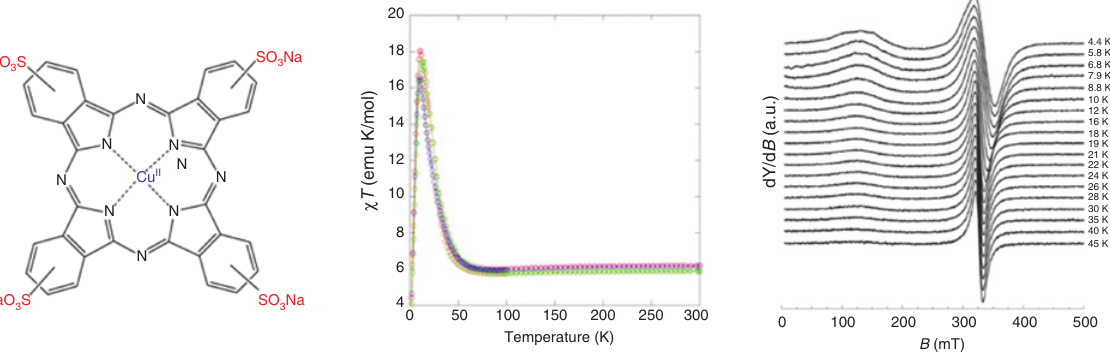
Figure 22: Left: phthalocyanines tetrasulfonates sketch [M = Co(II), Ni(II),Cu(II)]. Middle: magnetic behavior as function of temperature for CuPcTS @Co (red), CoPcTS @Co (blue), and NiPcTS0@Co (green). Right: thermal variation of the X band EPR spectrum of CuPcTS 0 0 Adapted with permission from [101]. Copyright 2014 American Chemical